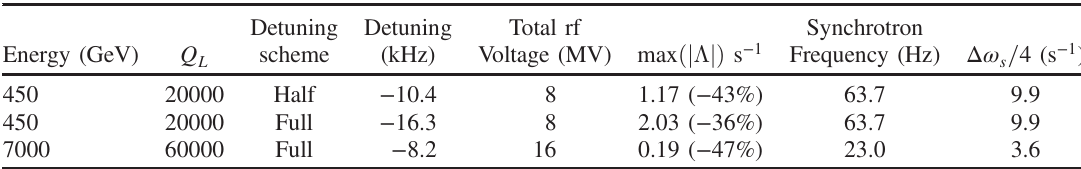
TABLE V. Maximum value of j Λ n j over all n caused by the impedance of the eight cavities at the fundamental. OTFB Off. Rf station optimized with